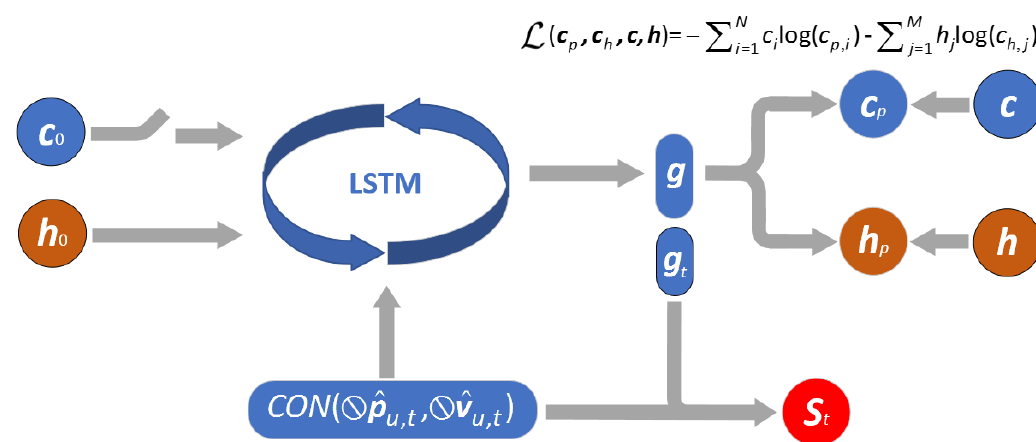
Figure 2. Grid network architecture in the supervised learning experiment. The recurrent layer is an LSTM with 128 hidden units. c and h represent the place cell activations and head-direction cell activations,